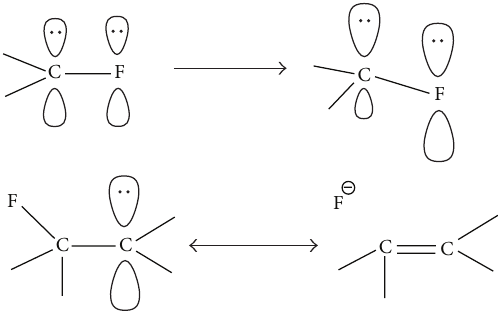
Figure 3: Hyperconjugation between atom and